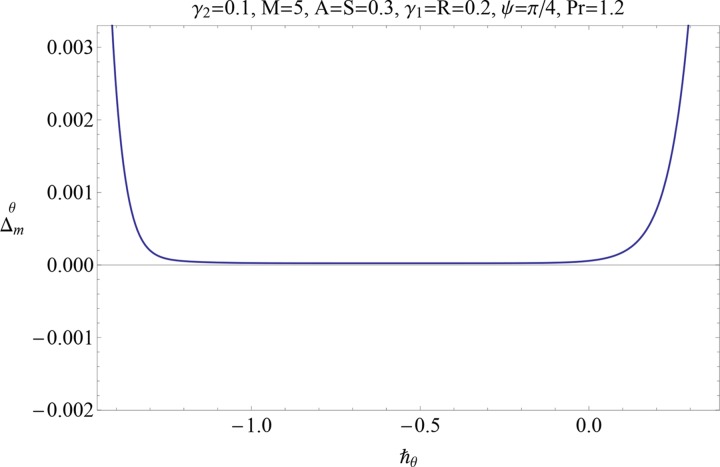
Residual error for ℏθ.